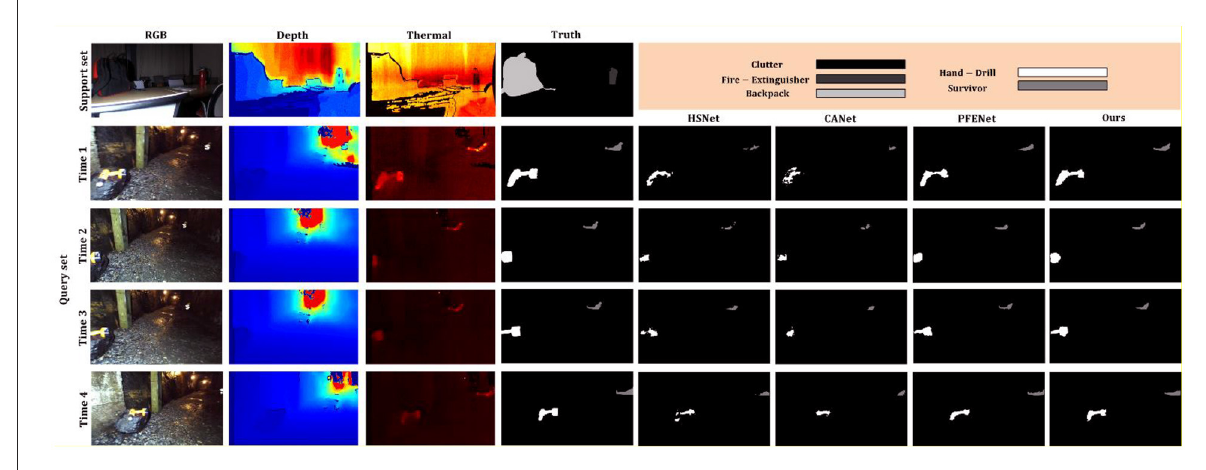
FIGURE2 Qualitative results (one-shot) of HSNet, CANet, PFENet, and our method on PST900’s time-series images.